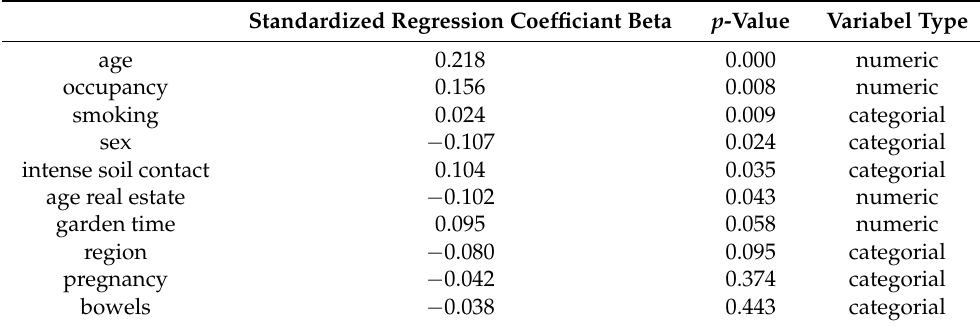
Table 2. Hierarchical regression analysis. Explanation of the BLL observed in the study population and